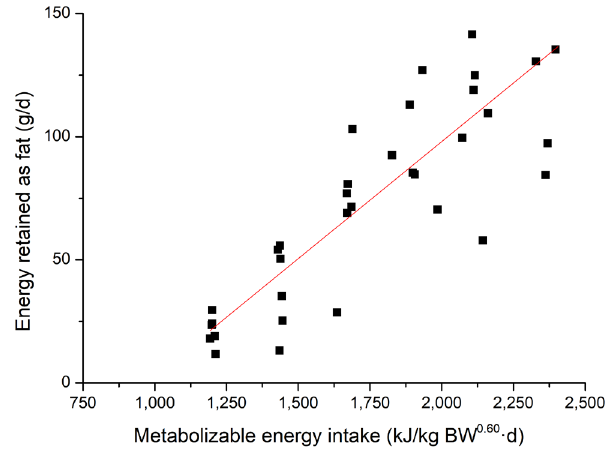
Figure 2. Linear relationship (parameters±standard error) between metabolizable ) for all pigs ( ■ ). RE , g/d = energy intake (MEI) and energy retained as fat (RE p p (±0.009)×MEI, kJ/kg BW 0.60 d –92.21 (±17.189), R 2 = 0.75, p<0.01, n =